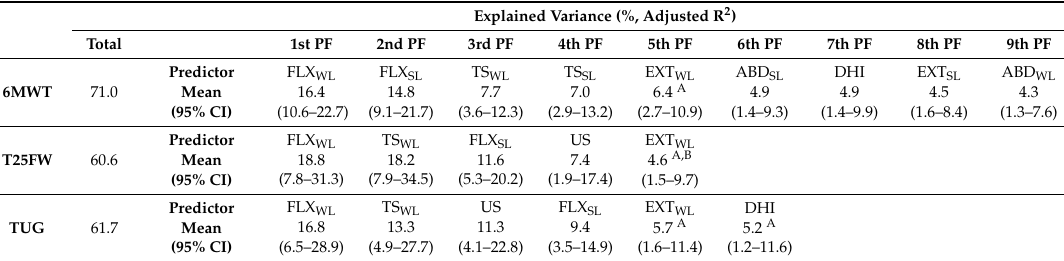
Table 3. Relative Weight Analysis with the 6MWT, T25FW and TUG as the dependent variables and their significant ( p < 0.05) predictive factor (PF) in people with multiple sclerosis ( n = 61). Explained Variance (%, Adjusted R 2